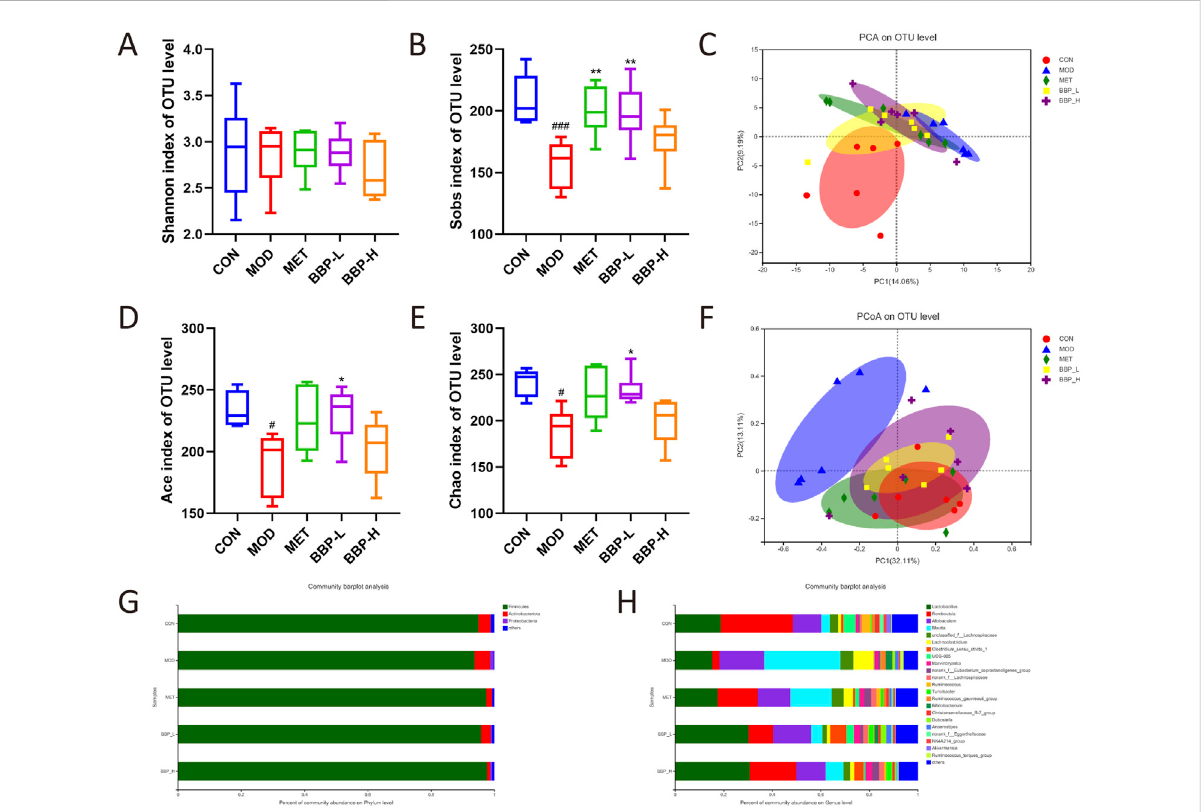
The results ofmicrobialdiversity and community compositionanalysis. Shannon index (A) , Sobs index (B) , PCA analysis (C) , Ace index (D) , Chao indexes (E) , PCoA analysis (F) . The percent of community abundance atthe phylum (G) and genus (H) levels. Values are presented as the mean ± SD, n = 6. # p < .05, ## p < .01, ### p < .001: model vs. control; * p < .05, ** p < .01, *** p < .001: treatment vs.